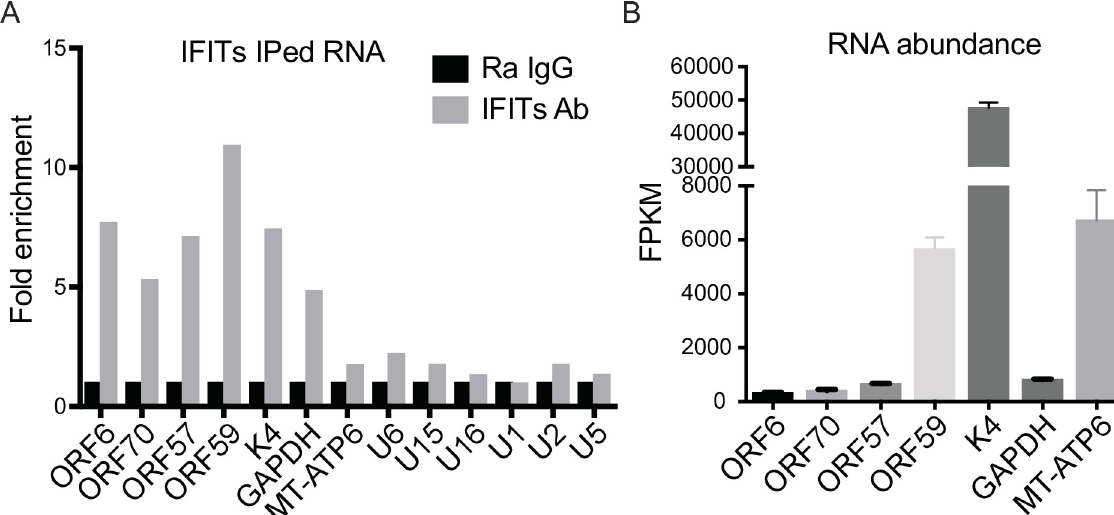
Fig 8. IFIT1, IFIT2 and IFIT3 immunoprecipitate KSHV mRNAs. A. Quantitation of RNAs immunoprecipated (IPed) with IFITs. iSLK cells were treated with 1 μ g/ml doxycycline to induce KSHV replication and cells were harvested at 48 hr for immunoprecipitation with IFIT1 and IFIT3 antibodies. qPCR was performed to measure IFIT1 and IFIT3 immunoprecipitated viral and cellular RNA. Fold enrichment over control immunoprecipitations are shown. B. Transcript abundance of selected KSHV genes highly upregulated by IFIT KD. Fragments per kilobase of transcript per million mapped reads (FPKM) from RNA sequencing of viral and control cellular genes are shown.